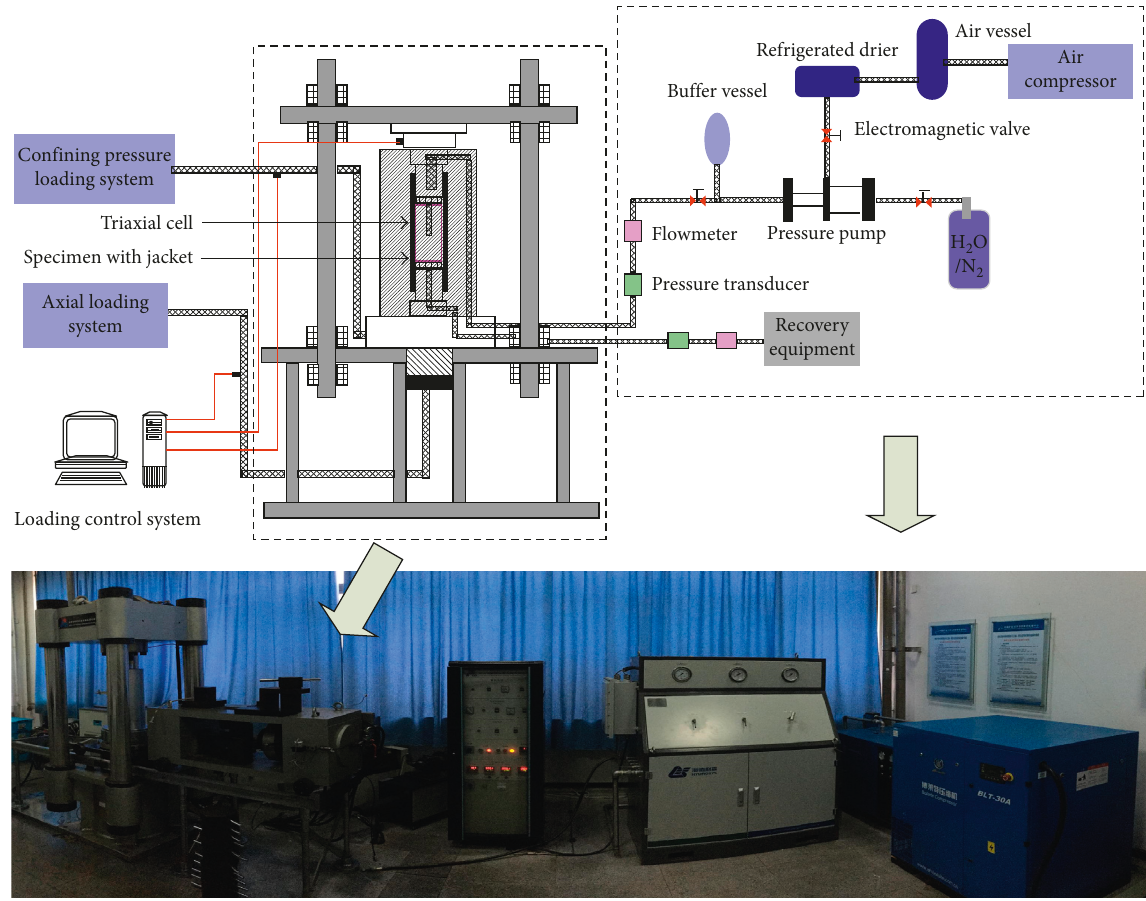
Figure 2: Testing equipment.